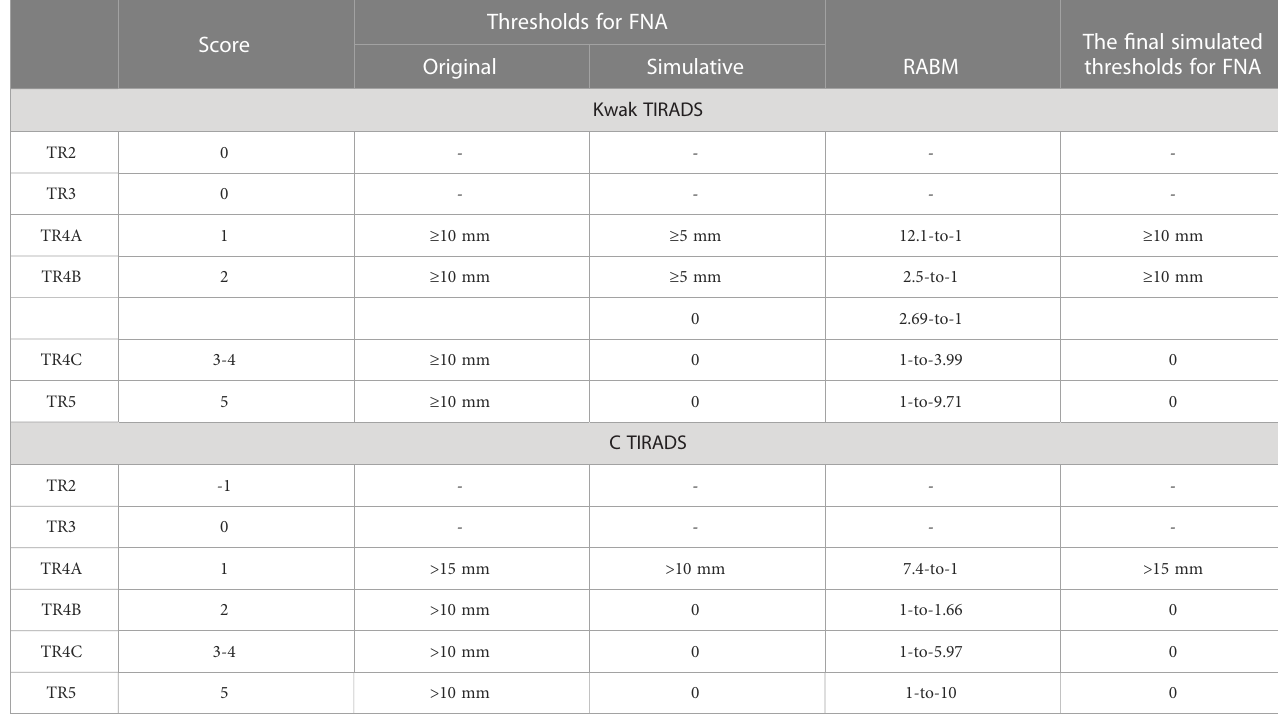
Thresholds for FNA